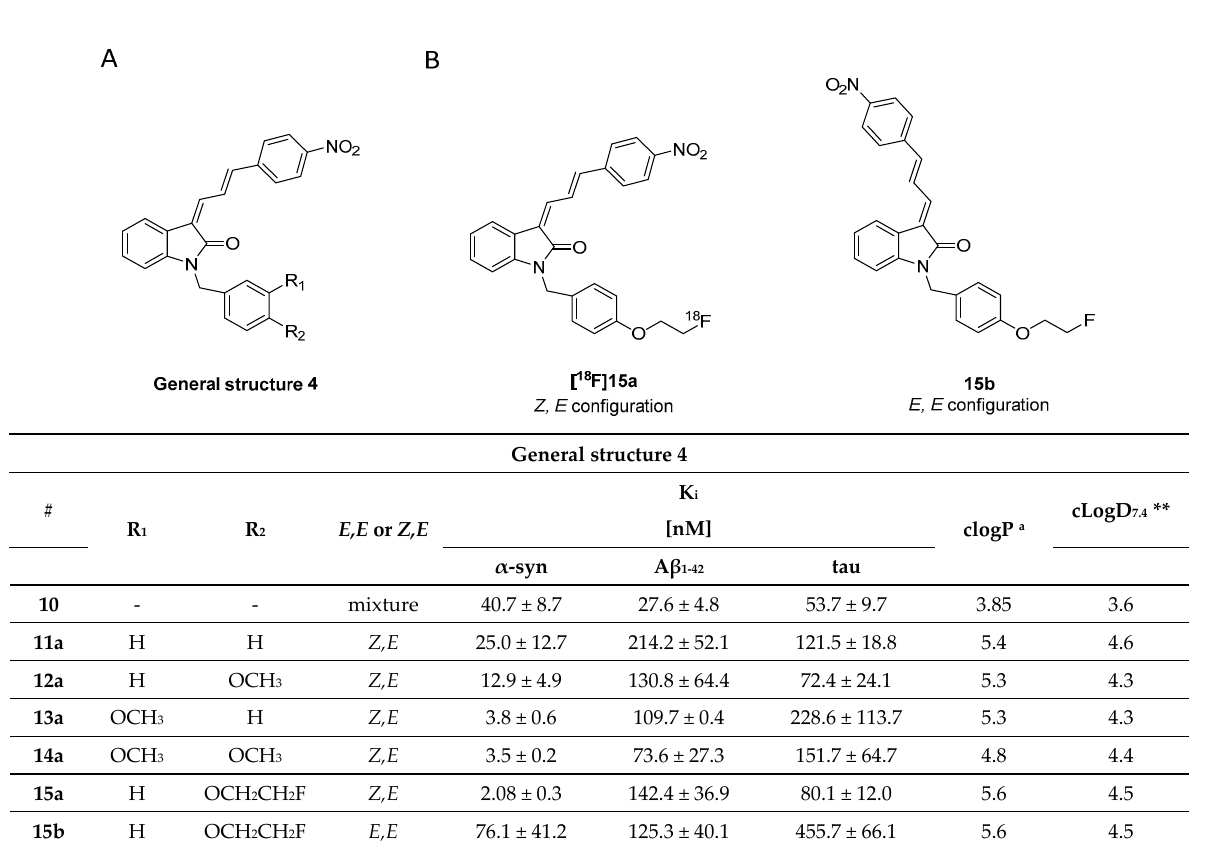
Figure 13. Chemical structure of 17 with binding affinity K i = 89 nM [106]. 3.4.2. Bithiazole Derivatives Bithiazole derivatives were reported as promising new ligands for the detection of neuropathological aggregates, including α -syn. Unfortunately, the only available litera- ture source, to date, is patented and no additional articles are available on the subject. Researchers from the Technical University of Munich developed these bithiazoles and among them compounds 18, 19 and 24 (Figure 14) showed high affinity for α -syn and good selectivity over A β 1-42 and tau fibrils (as determined by saturation binding assays). Several bithiazoles from the same family were identified as potential ligands for targeting A β and tau. Potential ligands for α -syn are summarized in Figure 14 with limited binding affinity data. Compound 18 demonstrated the highest affinity (K i = 3 nM) and a selectivity of 127-fold and >300-fold over A β 1-42 and tau, respectively. Additionally, compounds 20, 21, 22 and 23 (Figure 14) were also reported to be selective for α -syn, although no binding data was published [107]. Just recently, [ 18 F]S3-1 (Figure 14) a novel structurally related α -syn PET tracer was evaluated in rats, NHPs and humans following a conference abstract [108]. [ 18 F]S3-1 showed binding affinity of 3 nM for α -syn and high selectivity of 120-fold for A β and tau. Brain kinetics were investigated in E46K rats demonstrating statistically significant difference between E46K and health controls. Furthermore, in NHPs initial brain update was up to 1.4% ID and the SUV was 1.3 at 30 min with rapid clearance (SUV